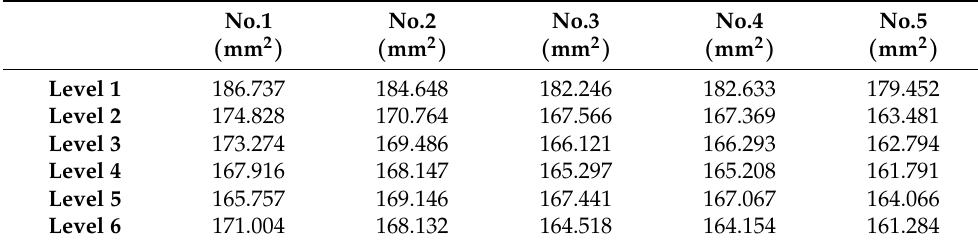
Figure 3. ( a ) workpiece and measurement; ( b ) workpiece processing view. Table 2. Measurements after ECM.